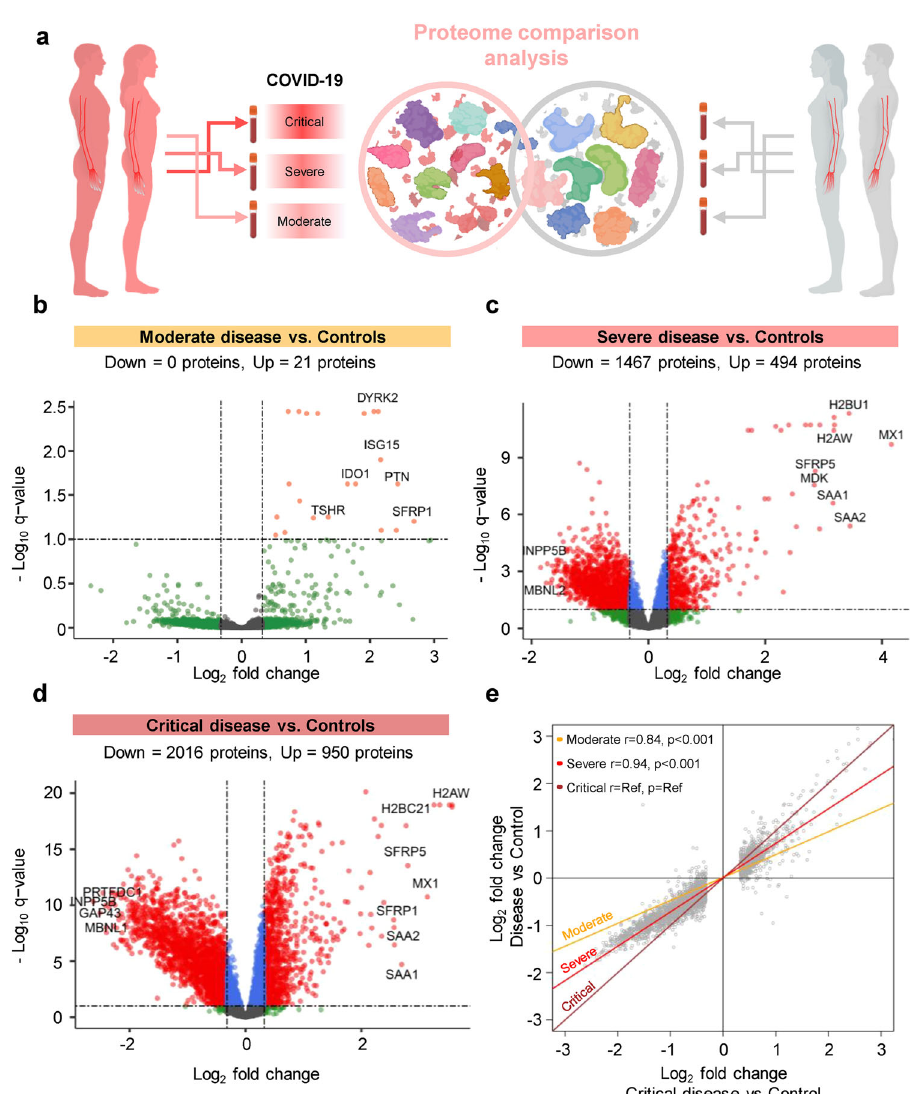
Fig. 3 The plasma proteome shows increasing perturbation with COVID-19 severity in non-pregnant individuals. a Graphical representation showing the comparison of plasma proteomes between each classi fi ed subset of non-pregnant COVID-19 cases and controls. b Volcano plot showing the proteins modulated in moderate COVID-19 cases compared to controls. Red = proteins with q < 0.1 and fold change >1.25, green = proteins with q ≥ 0.1 and fold change >1.25, gray = proteins with q ≥ 0.1 and fold change ≤ 1.25, blue = proteins with q < 0.1 and fold change ≤ 1.25. c Volcano plot showing the proteins modulated in severe COVID-19 cases compared to controls. d Volcano plot showing the proteins modulated in critical COVID-19 cases compared to controls. e Comparison of the magnitude of proteomic changes among non-pregnant COVID-19 case subsets, using the comparison between critical cases vs. controls as the reference. Spearman ’ s correlation and p-value are provided for the moderate vs. control and severe vs. control contrasts compared to the reference. The proteins included in this analysis (gray dots) are those 2966 identi fi ed as differentially abundant in the comparison between non- pregnant critically ill cases vs.